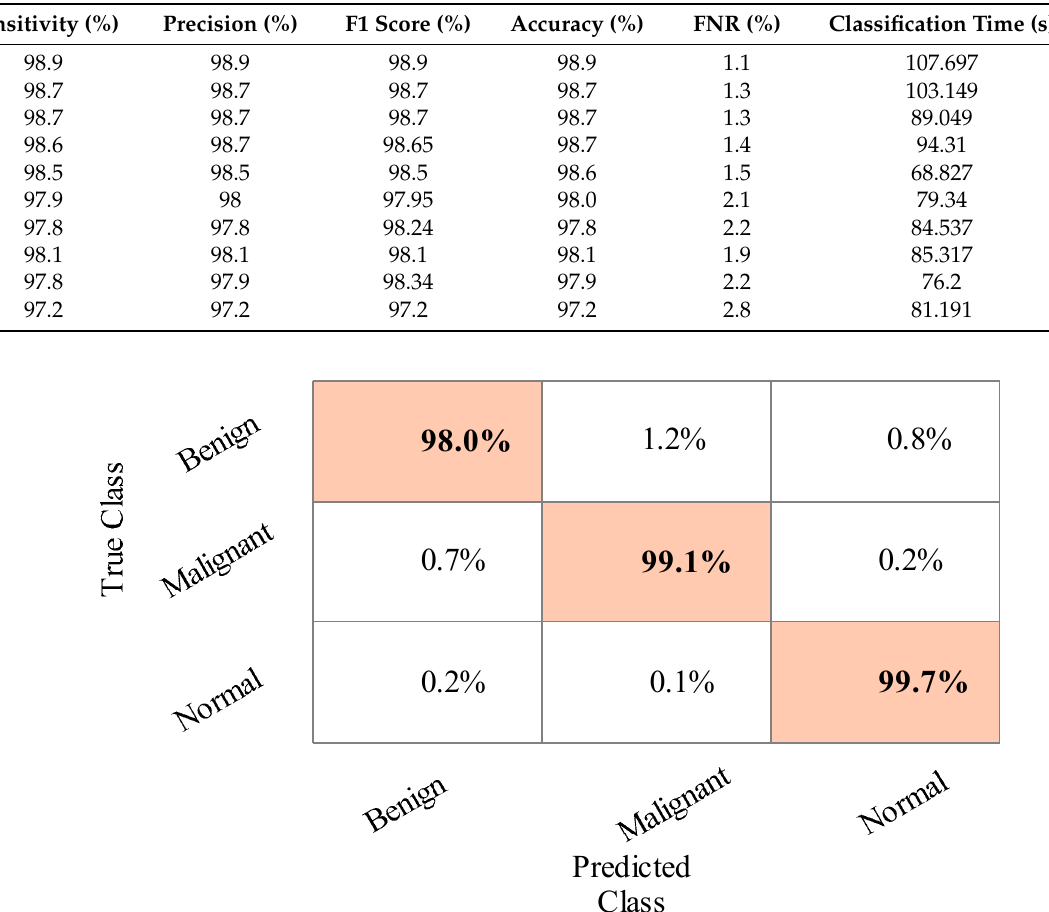
Figure 8. Confusion matrix of Cubic SVM for the training/testing ratio of 60:40.